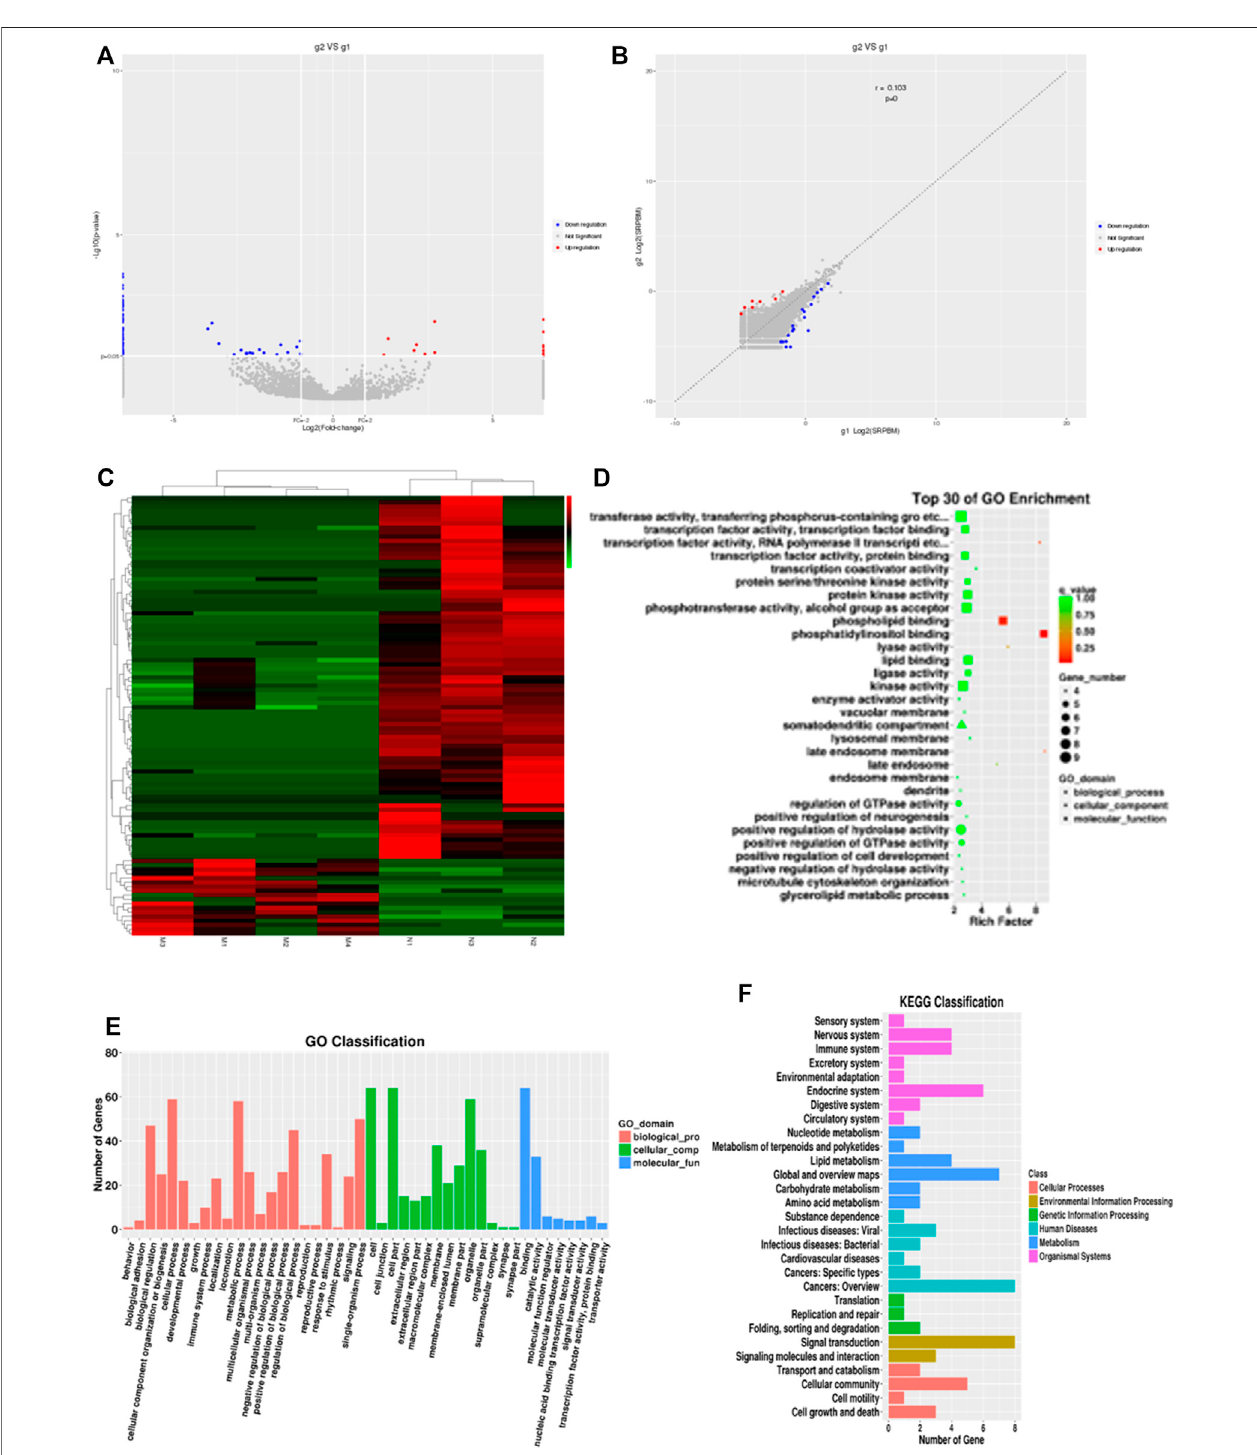
FIGURE 2 | CircRNAs expression pro fi le in HF in huaman by high-throughput sequencing. Scatter plot of circRNAs expression correlation, volcano map of differentially expressed circRNAs and Heatmap among samples (A – C) . the scatter plot of GO enrichment of differentially expressed circRNAs parental gene (D and E) . the analysis results of KEGG pathway in differentially expressed circRNAs parental gene (F) .